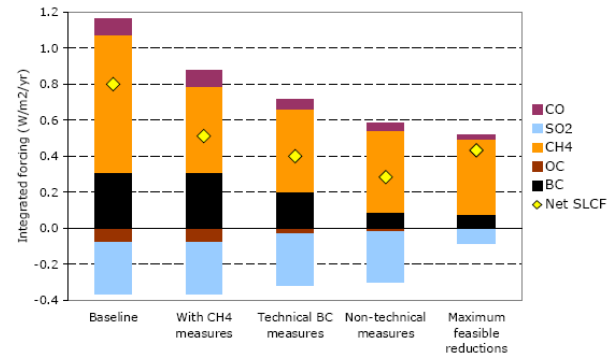
Fig. 23. Radiative forcing (integrated over 100 yr for the base- line, three control scenarios and the MFR on Air Quality regulation, global assessment by substance (UNEP,